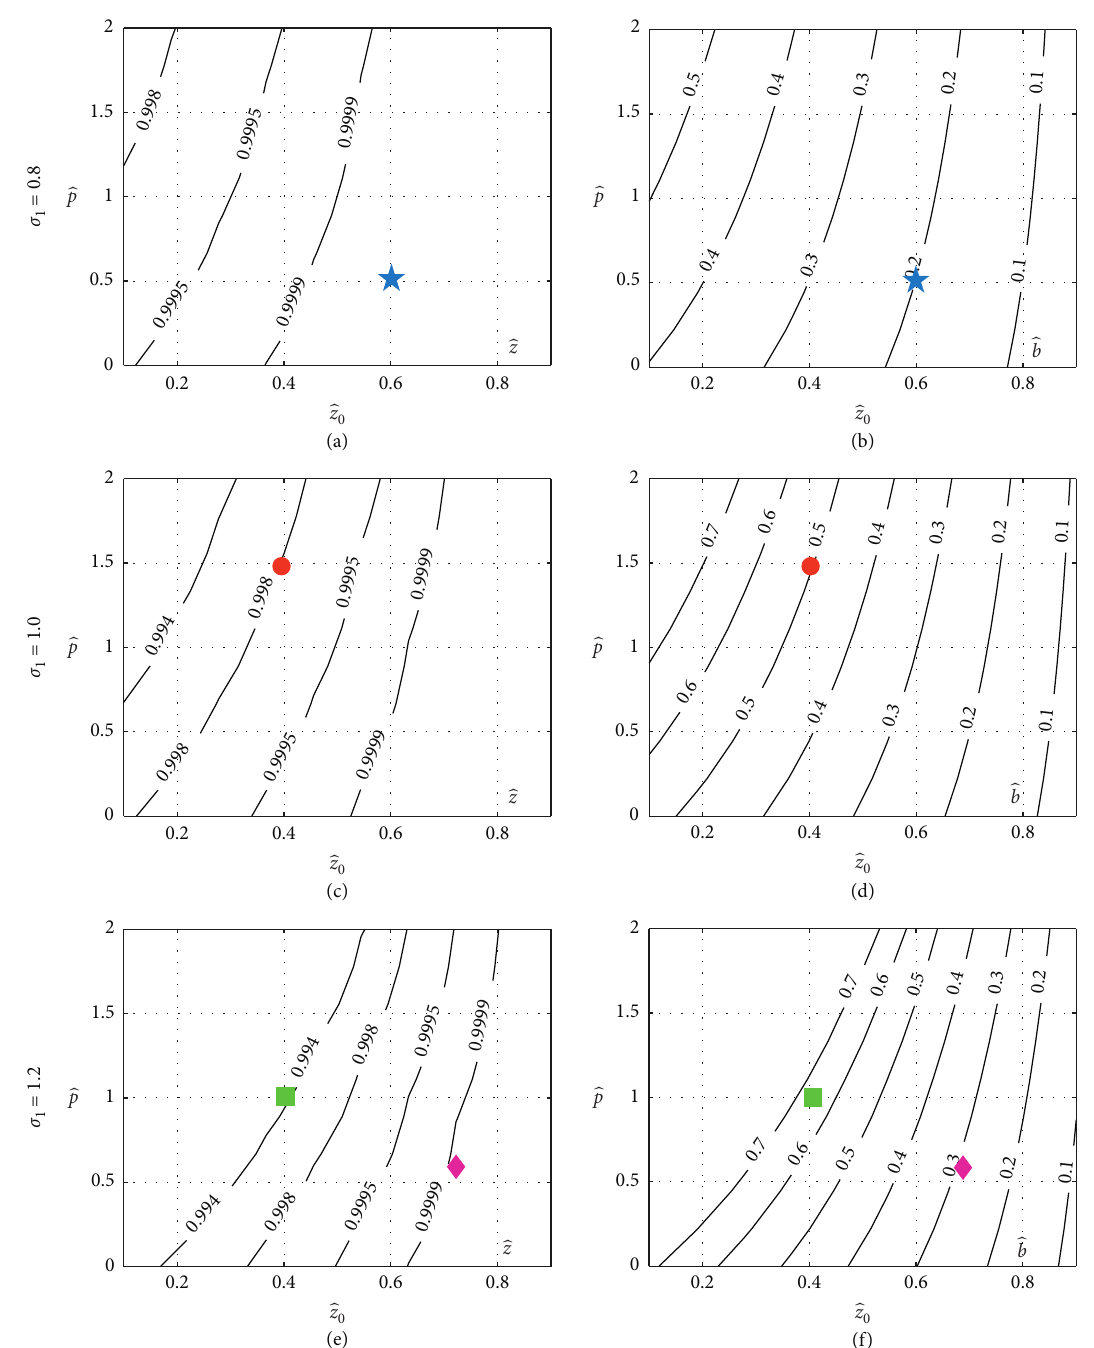
Figure 5: Contour plots for the design of an X -shaped suspension with QZS behaviour at large deflections: values of 􏽢 z at the inflection point and 􏽢 b for different combinations of σ